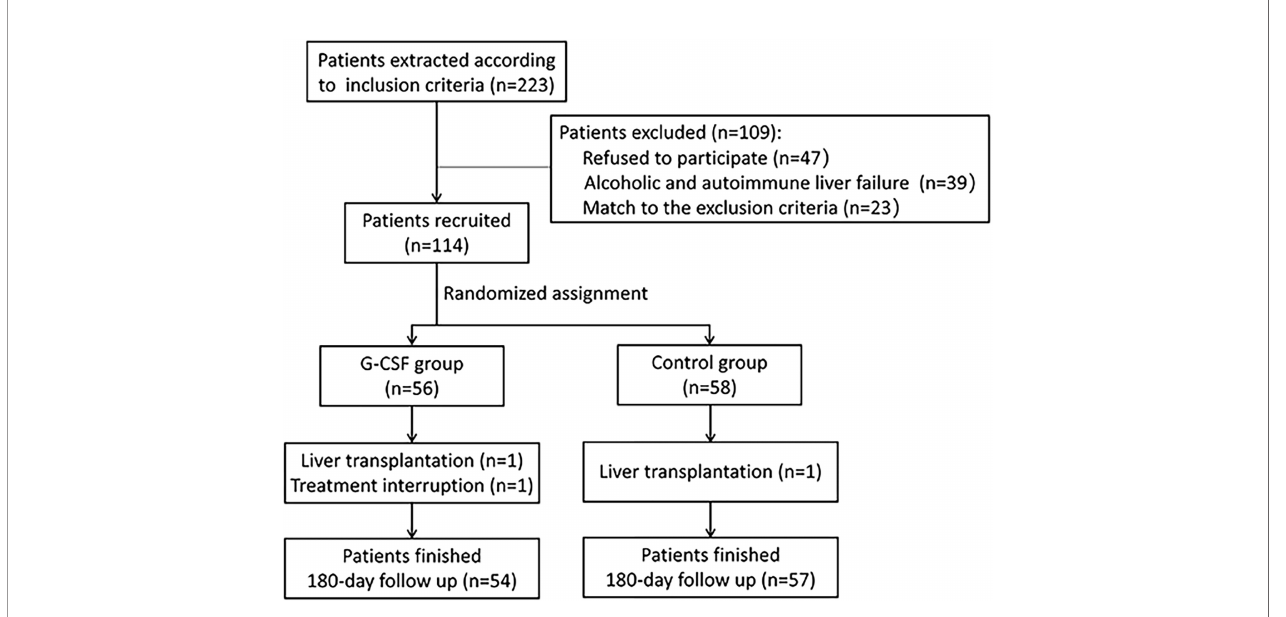
FIGURE 1 | Flowchart of screening and recruitment of patients with